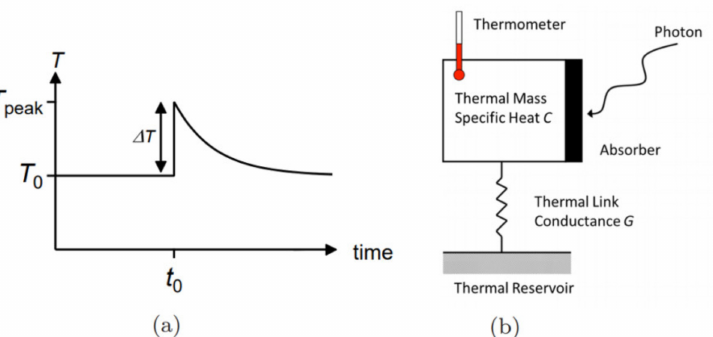
Figure 2. ( a ) The temperature response T (t) for a calorimeter. ( b ) Schematic illustration of bolometer working principle in a graphene detector, C (heat capacity) and the thermometer function are provided by the electron subsystem. G (thermal conductance) is provided by the coupling to the contacts and substrate as well as emitted Johnson noise. Reprinted with permission from ref.